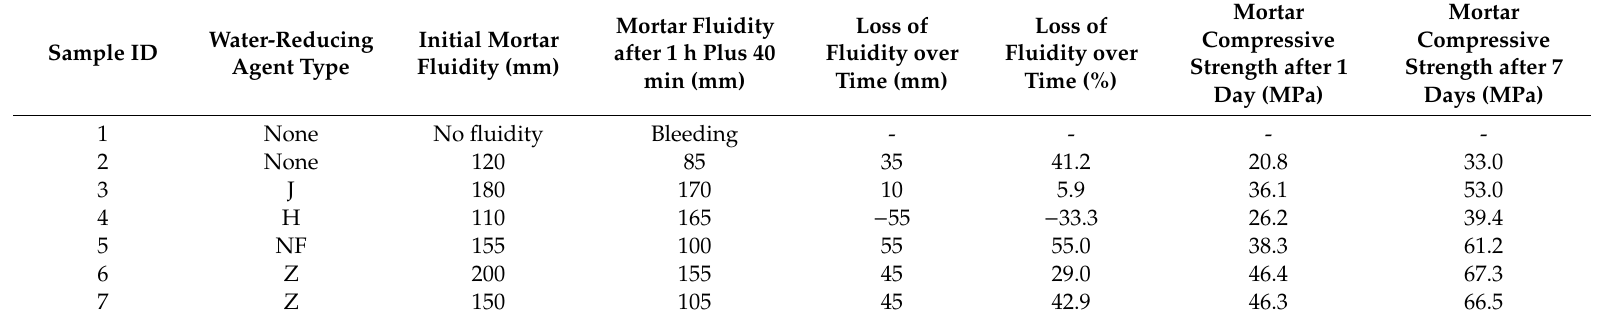
Table 6. The fluidity and compressive strength of cement